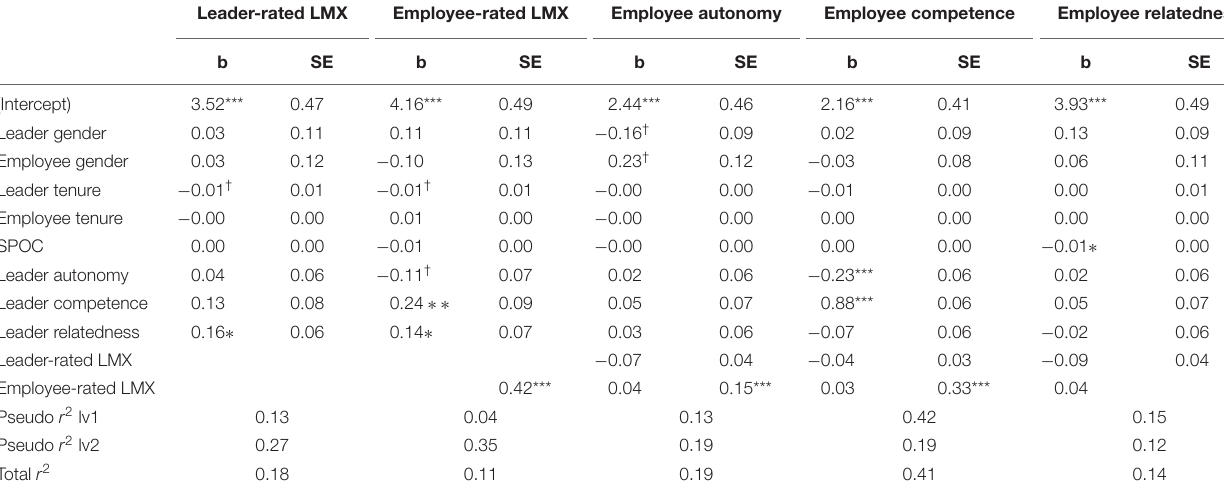
TABLE 5 | Hierarchical regressions per psychological need. Leader-rated LMX Employee-rated